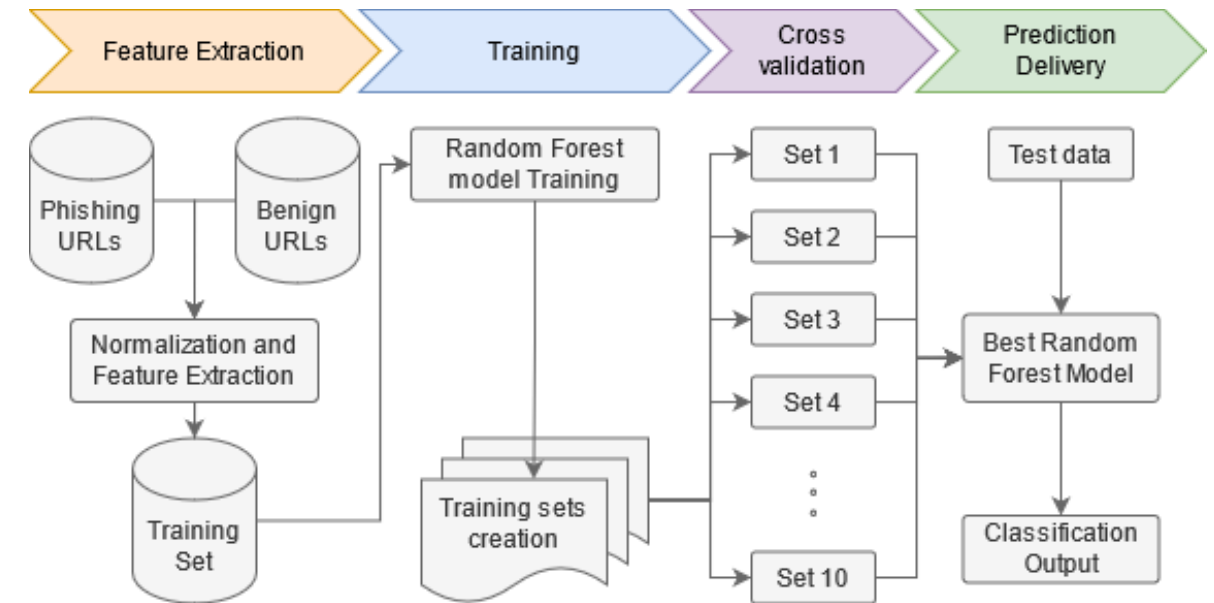
Figure 2. High-level description of the methodology applied to Random Forest model.